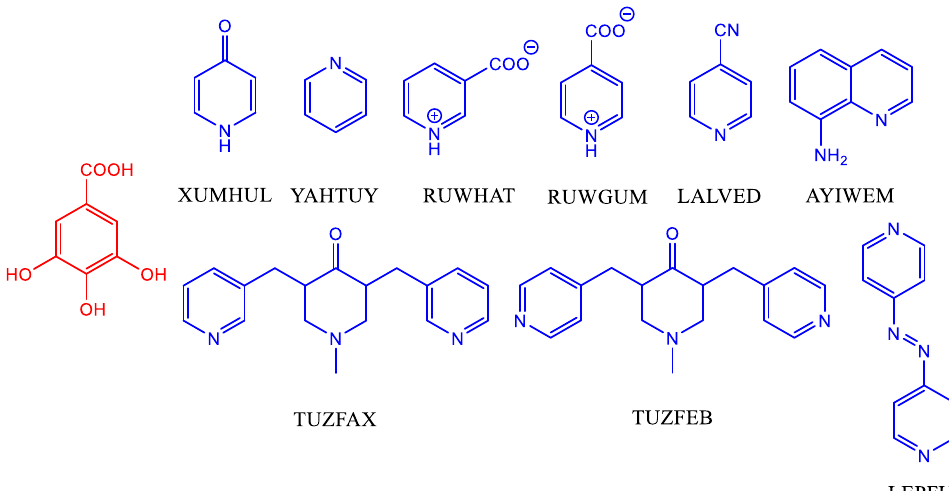
thon (Tables S2 and S3 of